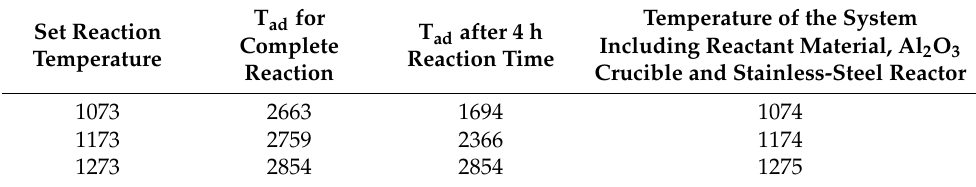
Table 3. Temperature increment at different reaction conditions, calculated by HSC 9 software (temperatures are given in K unit).